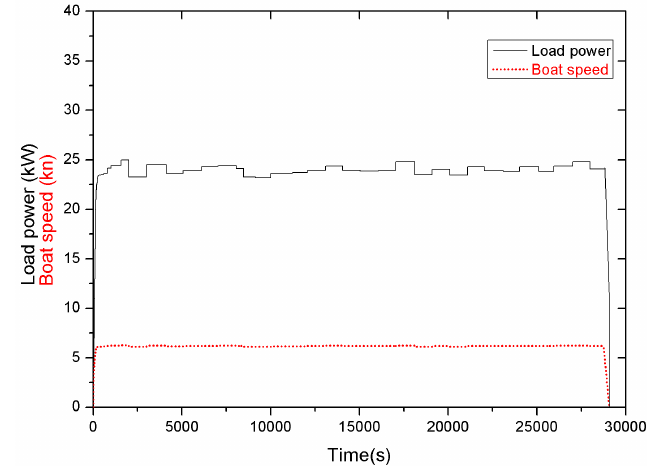
Figure 6. Load and speed profiles for cruising.